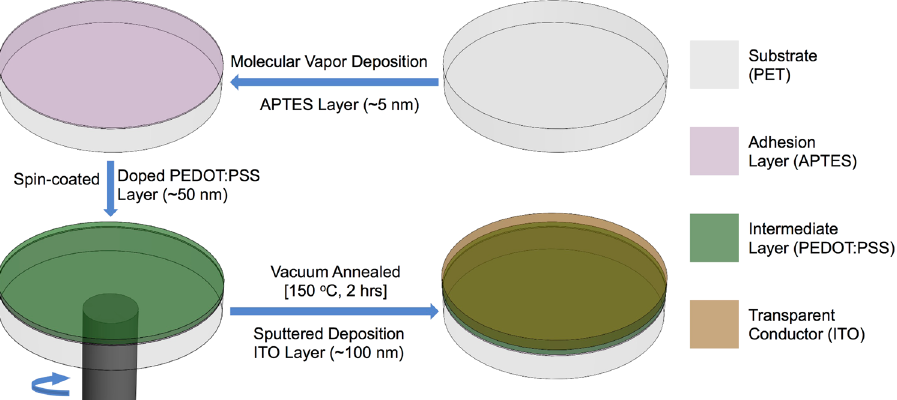
Fig. 1 Schematic of step-by-step deposition process of sputtered ITO fi lms on spin-coated EG-doped PEDOT:PSS layer on APTES-treated PET